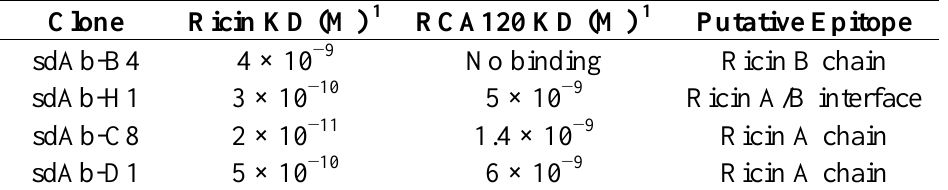
Table 1. Affinities of parental sdAb towards ricin and RCA120.